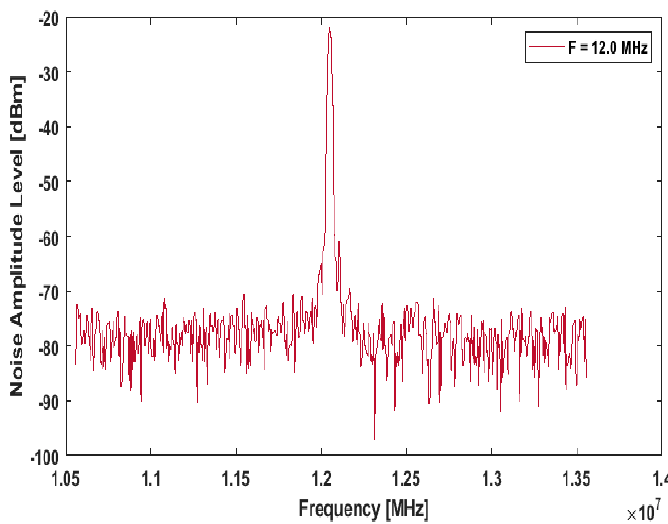
Figure 11. Waveform at 9 MHz.